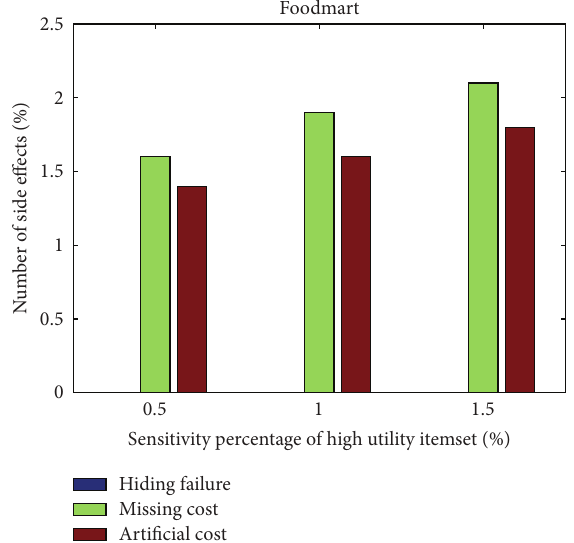
Figure 6: Fitness values in different percentages of sensitive high utility itemsets in the simulation dataset.